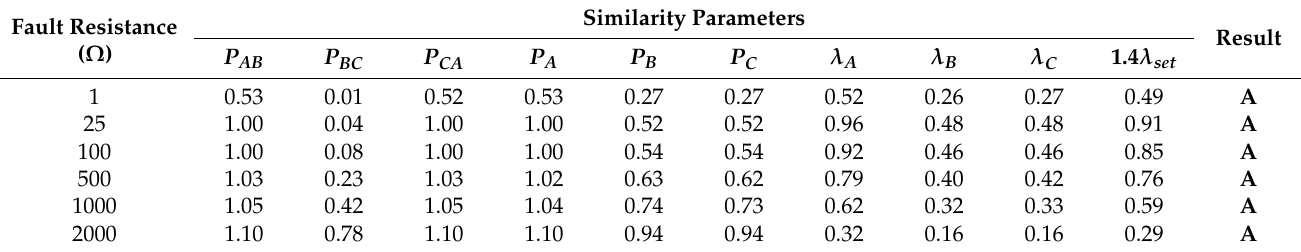
Table 3. Similarity parameters and faulty phase selection results.